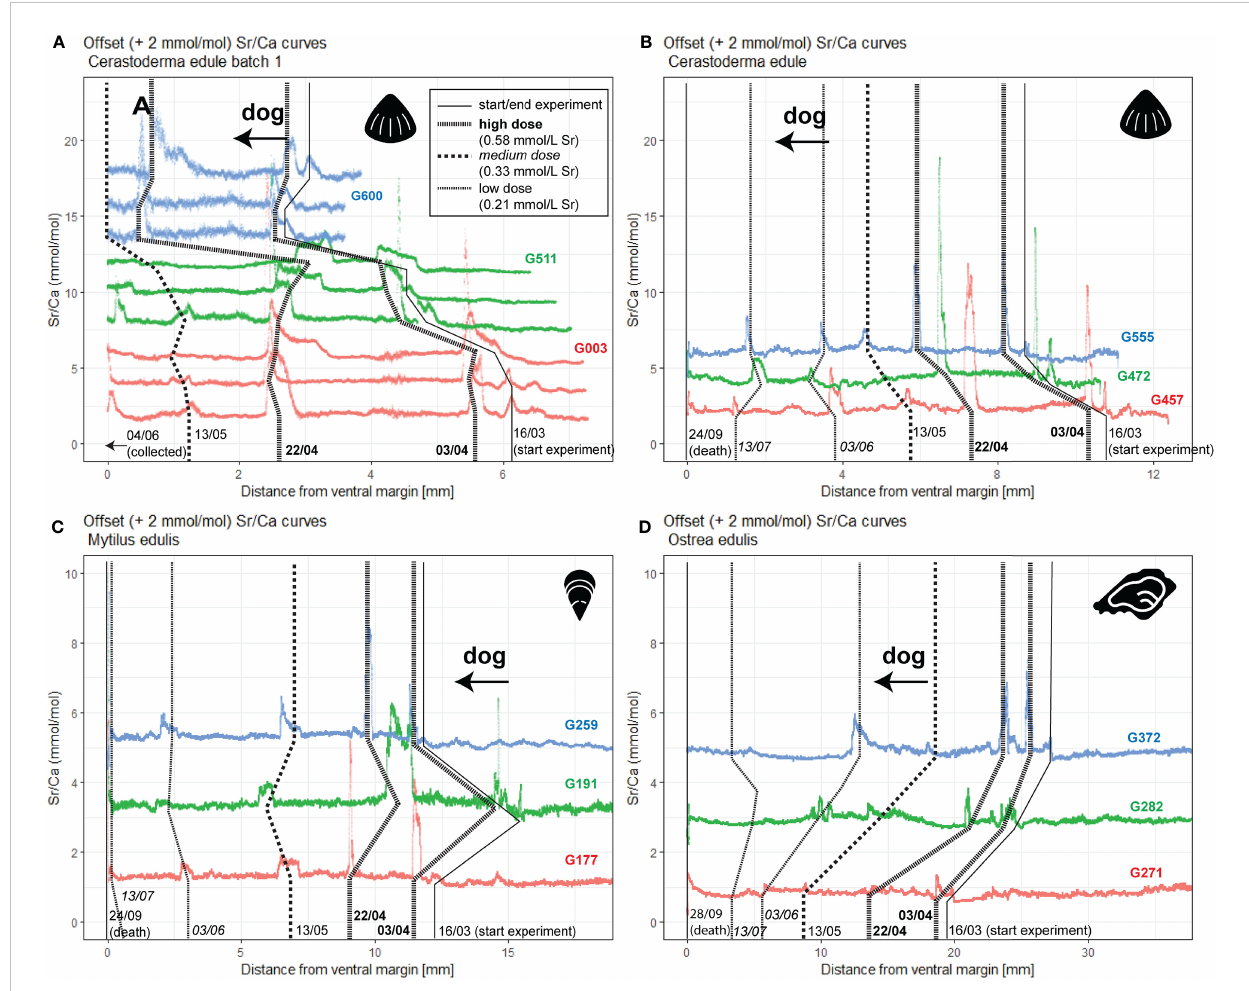
FIGURE 3 LA-ICP-MS Sr/Ca records through all aragonitic cockles (A, B) , calcitic outer shell layers of mussels (C) and foliated calcite in oysters (D) considered in this work. Records from subsequent specimens are indicated in different colors and offset by 2 mmol/mol from each other to promote visibility, with the lowest record showing true Sr/Ca values in agreement with axis labels. Parallel pro fi les within the same specimen (A) are also offset by 2 mmol/mol, with pro fi les closer to the outside of the shell plotted below pro fi les farther towards the inside of the outer shell layer. Lines connecting records vertically mark the beginning and end of the experimental period as recorded in the shells and the location of Sr peaks, with numbers at the bottom listing the dates (dd/mm) of the events. Doses of Sr peaks are indicated with different lengths of line dashes (see legend in (A) : high dose; 7.7-fold increase in [Sr] w ; administered at 03/04 and 22/04; medium dose; 4.4-fold increase in [Sr] w ; administered at 13/05; and low dose; 2.8-fold increase in [Sr] w ; administered at 03/06 and 13/07). Distance on horizontal axes is measured in scan direction (growth direction from right to left). “ dog ” = direction of